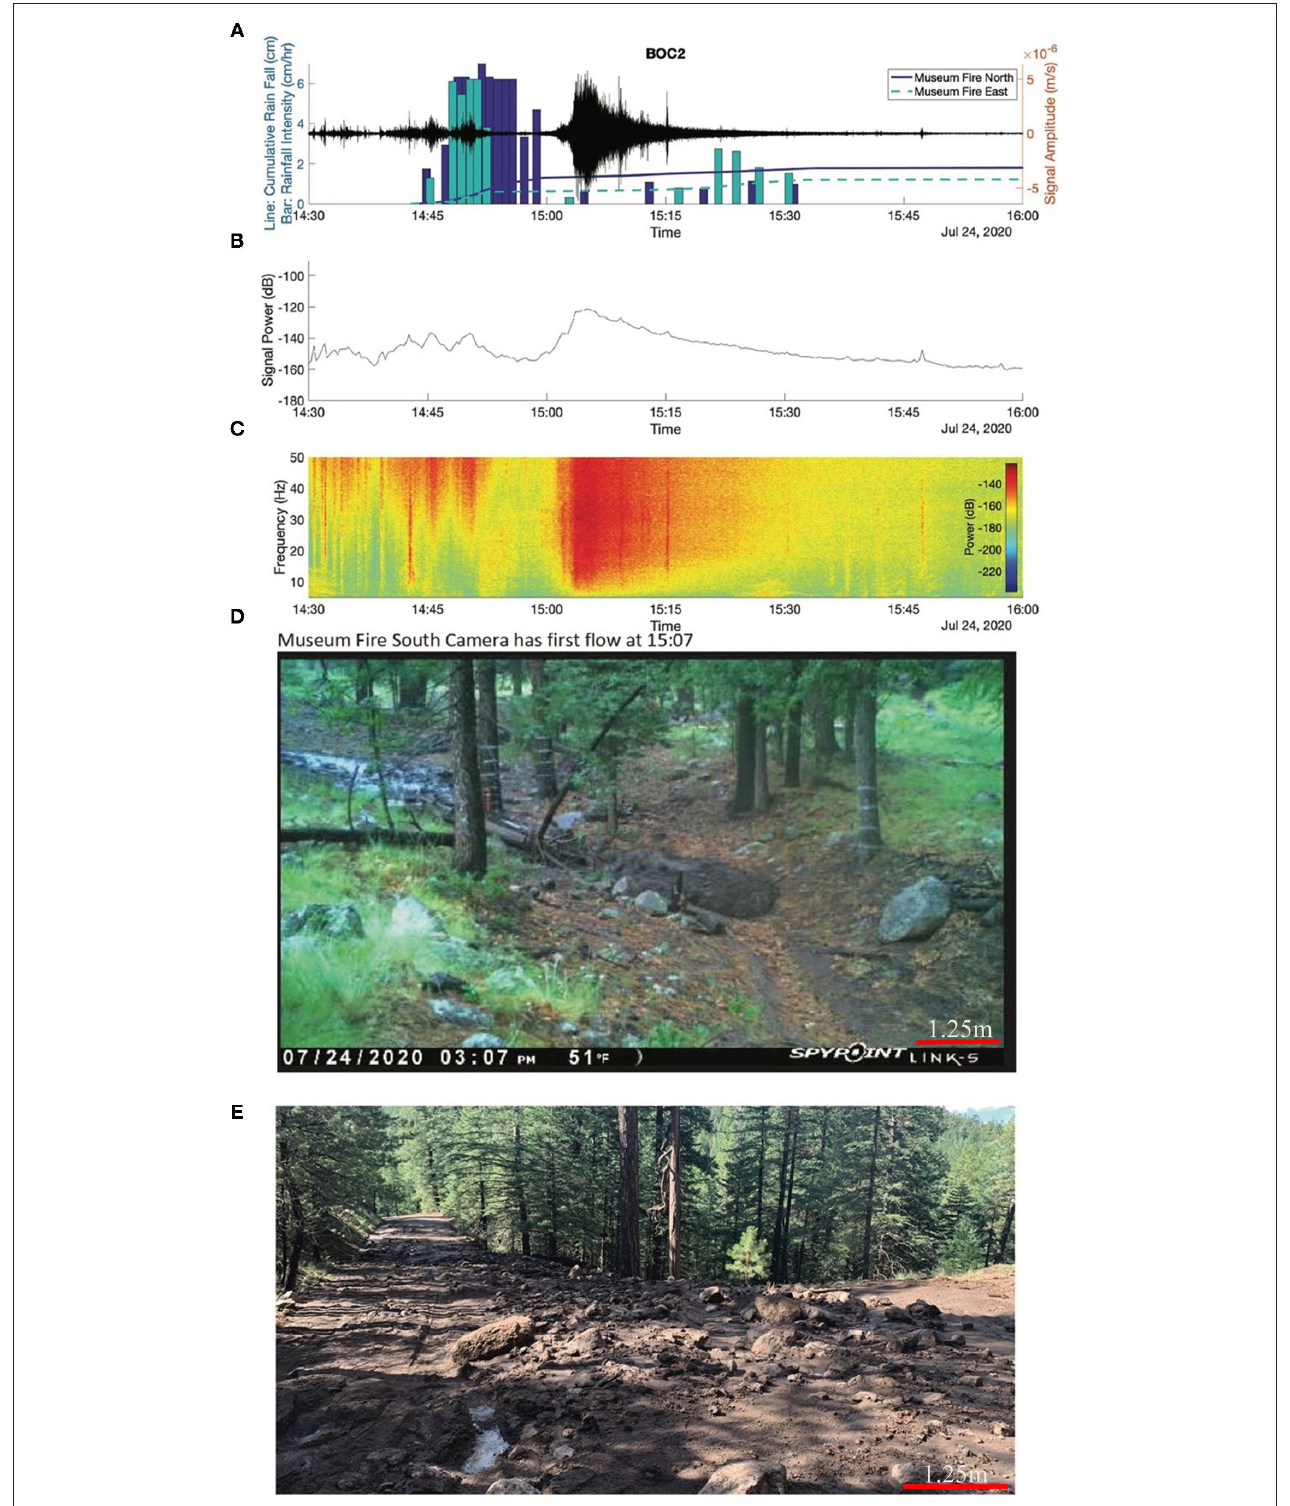
FIGURE 2 | (A) Ground velocity from seismic station BOC2 and rain gauge data from Museum Fire North and Museum Fire East gauges for event on July 24, 2020. (B) Signal power in dB (m/s) 2 . (C) Power spectral density plot. Power is in dB (m/s) 2 /Hz. (D) Game camera image of the mudflow arriving at camera location at 15:07. All times are presented in local time (Mountain Standard Time). (E) Photo of upper-basin debris flow deposits from this event.